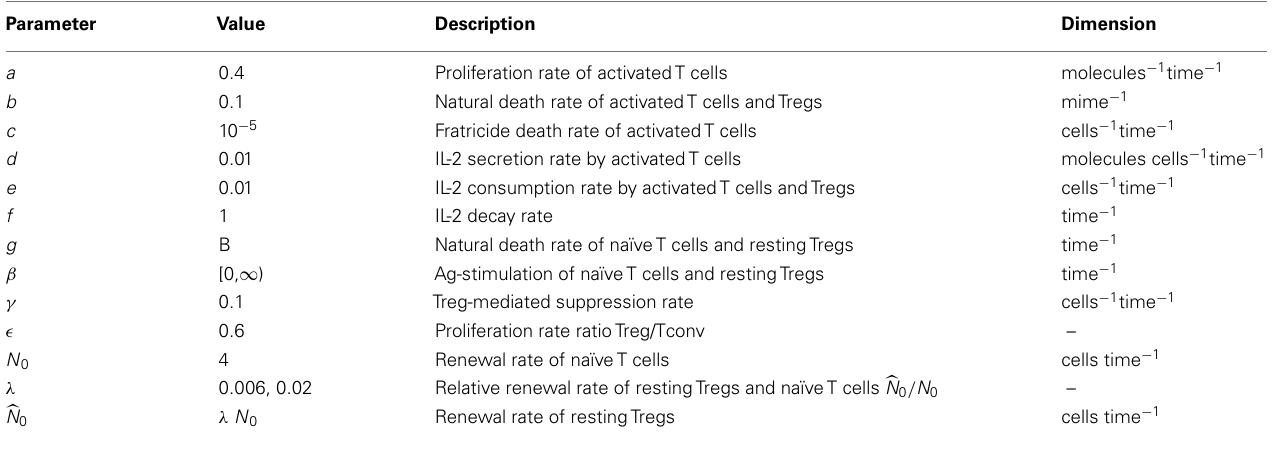
Table 1 | Parameters used for model analysis